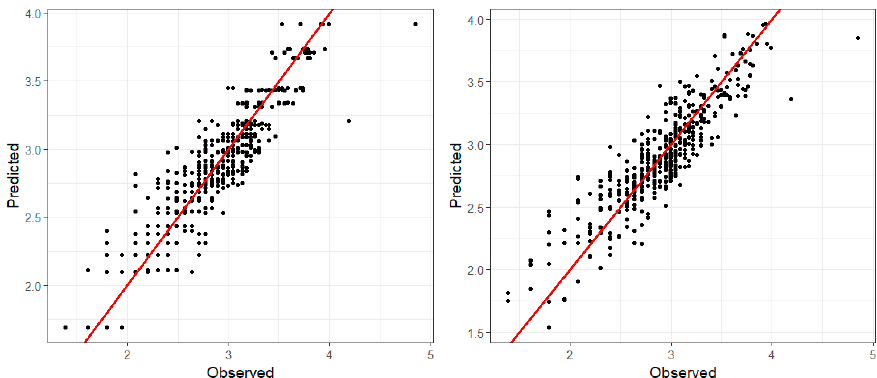
Figure 9. Plots of observed vs. fitted PM 2.5 values (in µ g / m 3 ) for models 9 ( left ) and 11 ( right ). The red line depicts the linear regression between the observed and the predicted values. Int. J. Environ. Res. Public Health 2020 , 17 , x